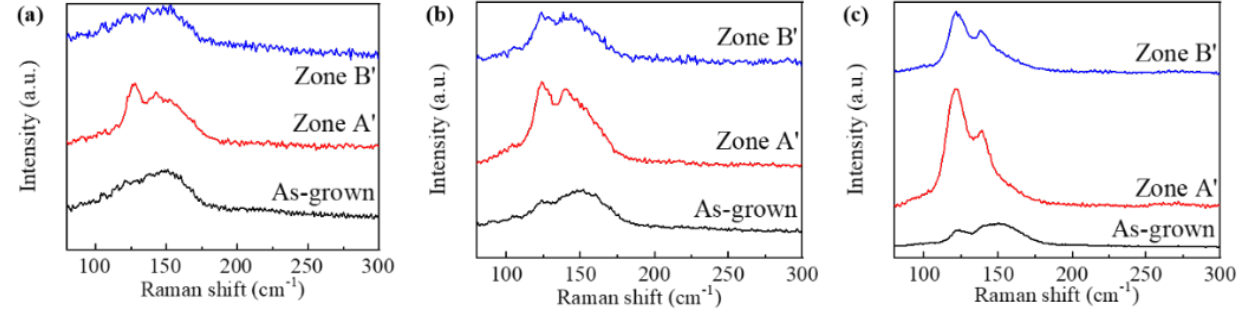
Figure 6. ( a ) Raman spectrum of pure GST in different regions, ( b ) Raman spectrum of 2:1 films in different regions, and ( c ) Raman spectrum of 2:2 films in different regions.